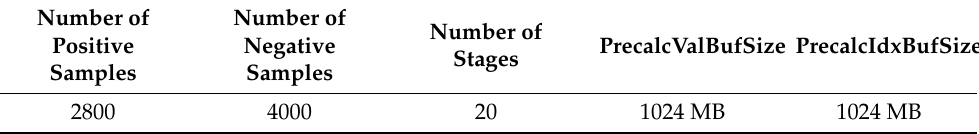
Table 4. General parameter settings.